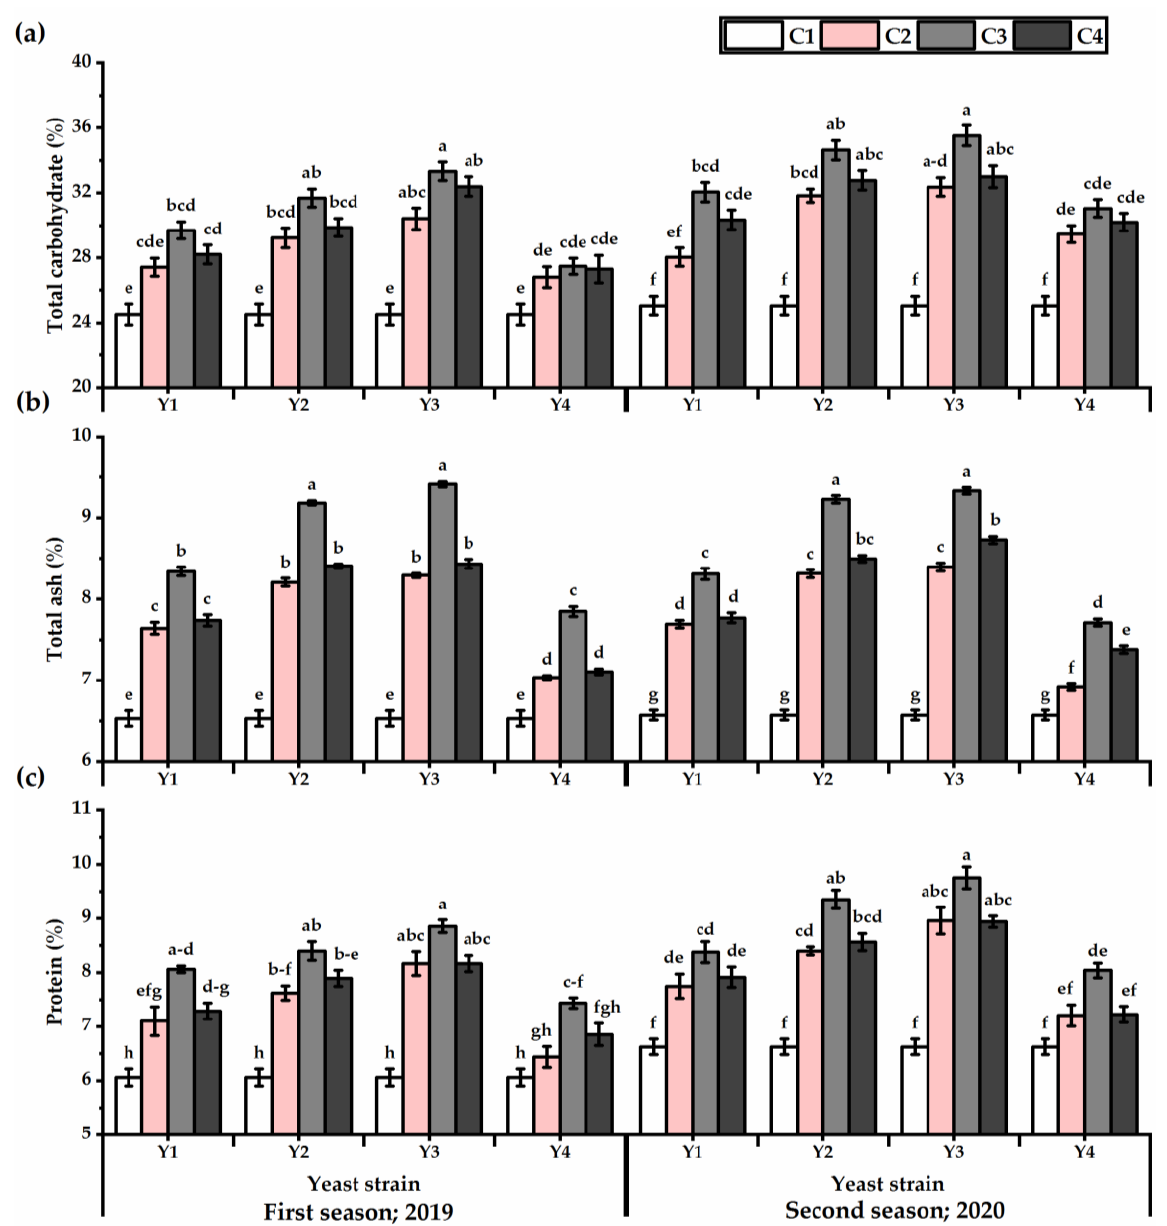
Figure 5. Total carbohydrates (%) ( a ), ash (%) ( b ), and protein (%) ( c ) of Plectranthus amboinicus (Lour.) Spreng. plants subjected to Rhodotorula muciligenese (Y1), Candida sake (Y2), Candida apicola (Y3), and Candida kunwiensis (Y4) yeast strains foliar application at 0 (C1), 1 × 10 4 (C2), 1 × 10 7 (C3), and 1 × 10 9 (C4) CFU mL − 1 concentrations during 2019 and 2020 seasons. Data are mean value ± SE. Means with different letters for each season significantly differed, using Tukey’s test at p ≤ 0.05 level, n = 15.3.5. DPPH and FRAP.